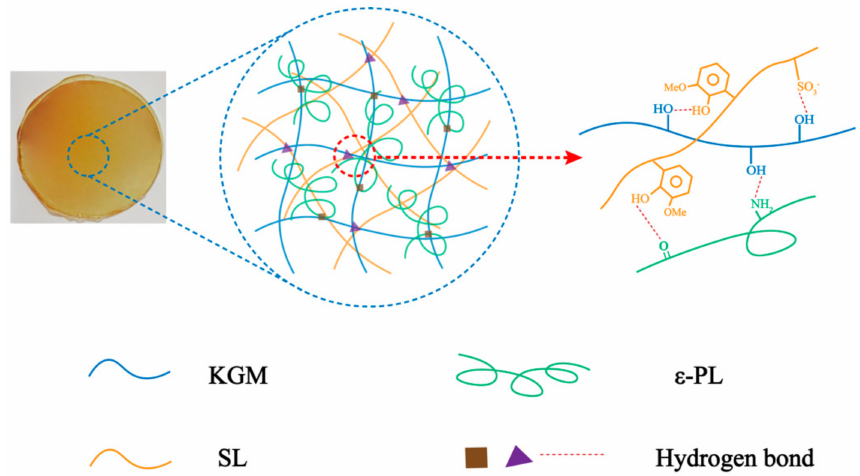
Figure 1. Mechanism